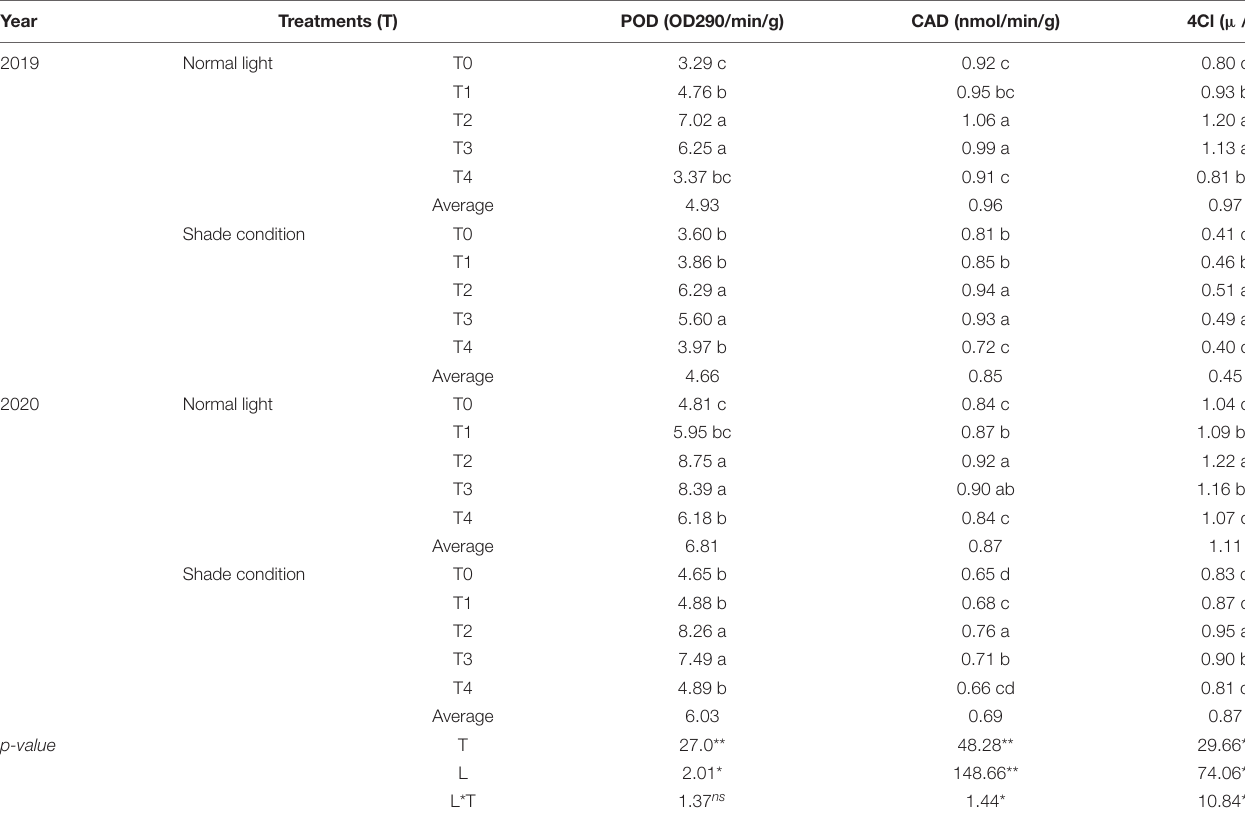
TABLE 4 | Effect of NH 4 + /NO 3 − on the lignin related enzymes activity under different light